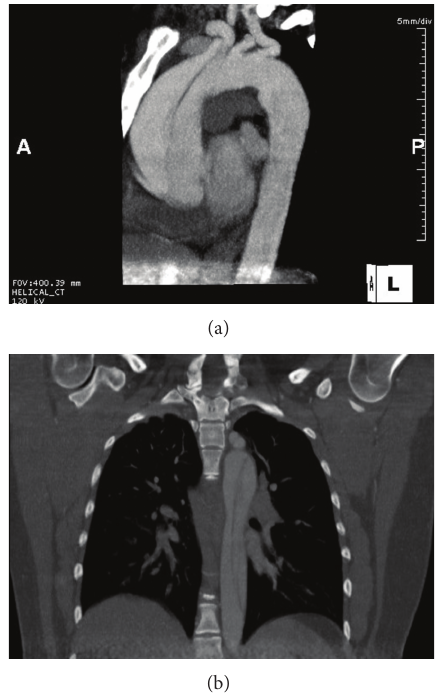
Figure 2: Sagittal and coronal views demonstrating acute dissection in ascending and descending